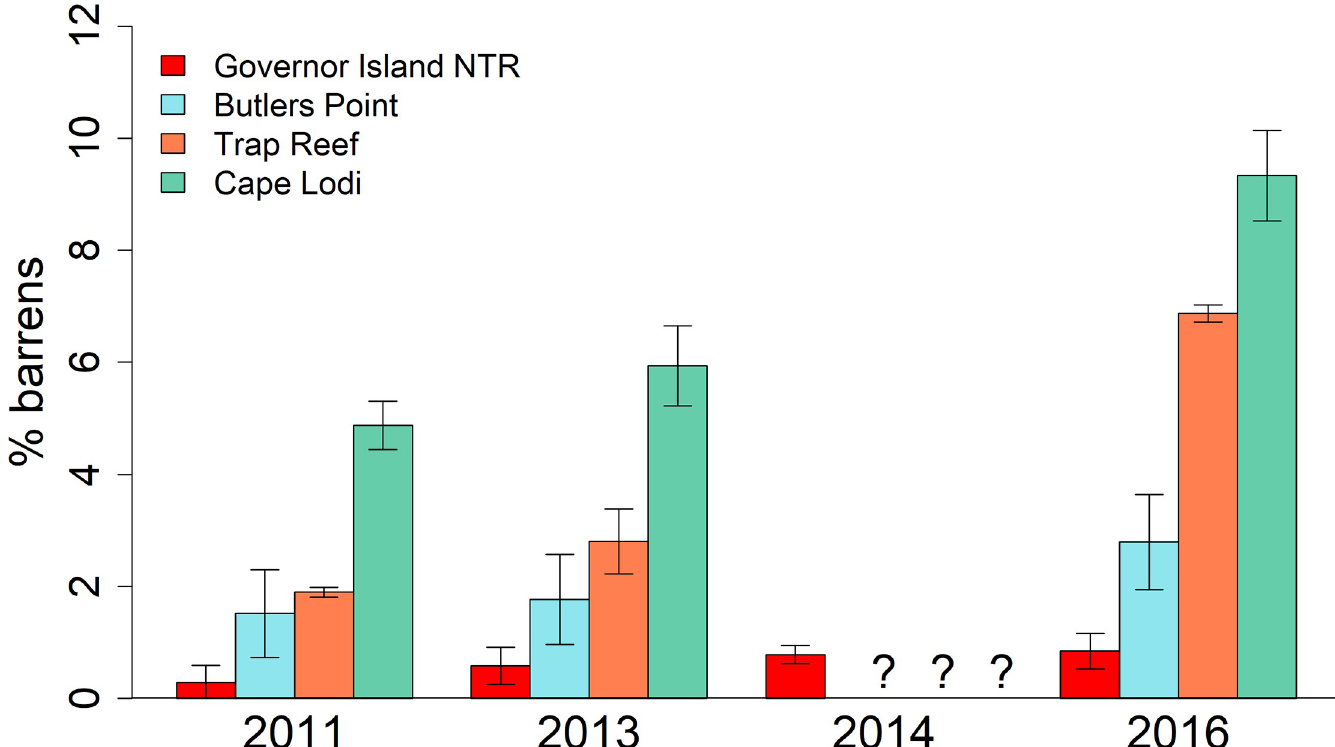
Fig 2. Percent barrens at each of the sites through time. Percent barrens were calculated as the precent of total images scored that were classified as barrens. Note that the control sites were not surveyed in 2014. Error bars are standard errors. Question marks indicate that no data was collected in 2014 for the control sites.